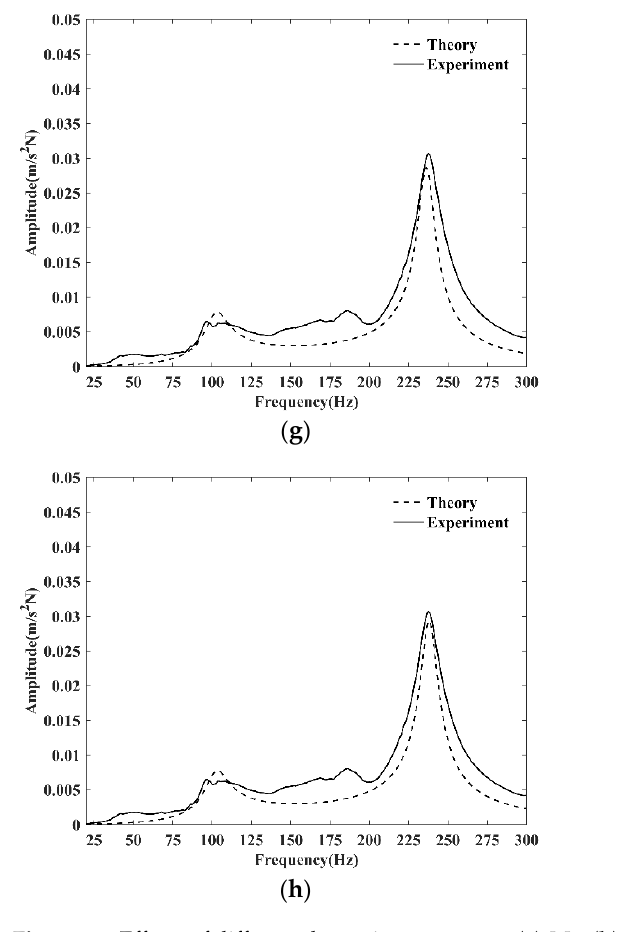
Figure 16. Effects of different dynamic parameters: ( a ) 𝑴 𝒂 ; ( b ) 𝜼 𝒂 ; ( c ) 𝑲 𝒐 ; ( d ) 𝑪 𝒐 ; ( e ) 𝑴 𝒕 ; ( f ) 𝜼 𝒕 ; ( g ) 𝑴 𝒇 ; ( h ) 𝜼 𝒇 .